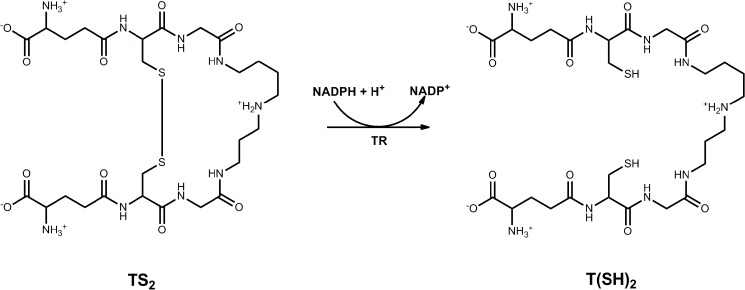
TR-catalyzed reduction of trypanothione disulfide (TS2) to the dithiol trypanothione (T(SH)2).